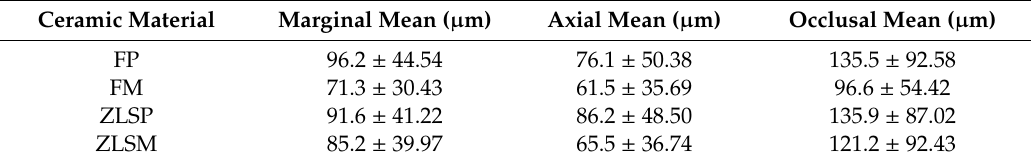
Figure 10. Mean values and standard deviation after cementing and thermocycling the ceramic crowns. Table 6. Mean values ( µ m) and standard deviations (SD) of the tested materials after cementing and thermocycling.